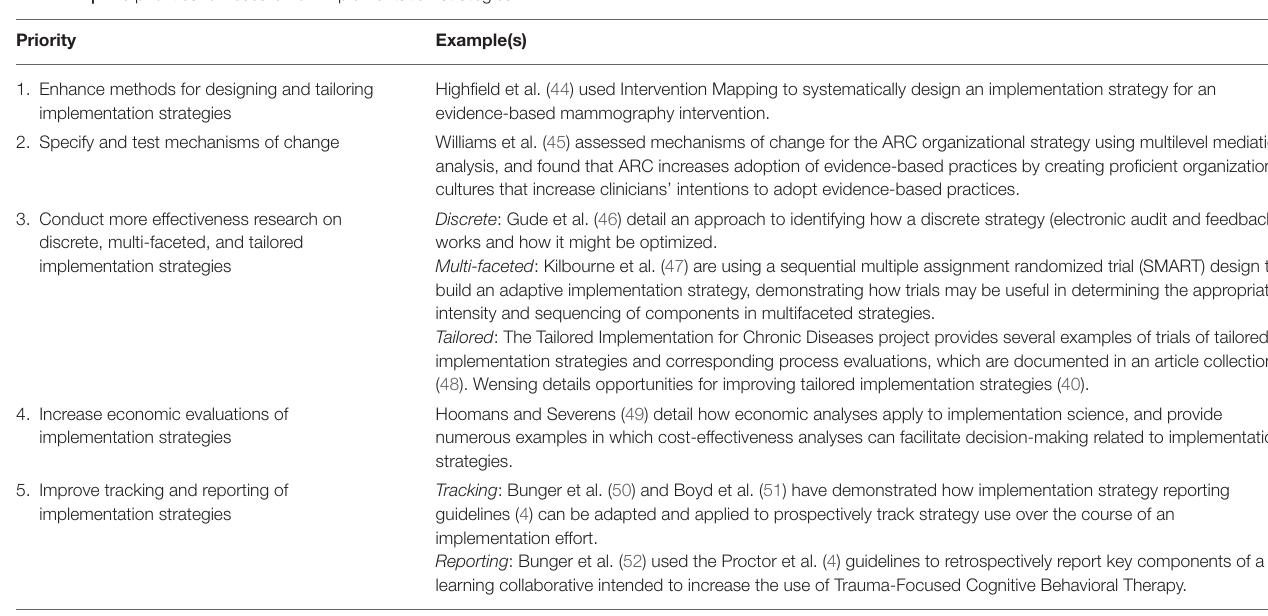
TABLE 2 | Five priorities for research on implementation